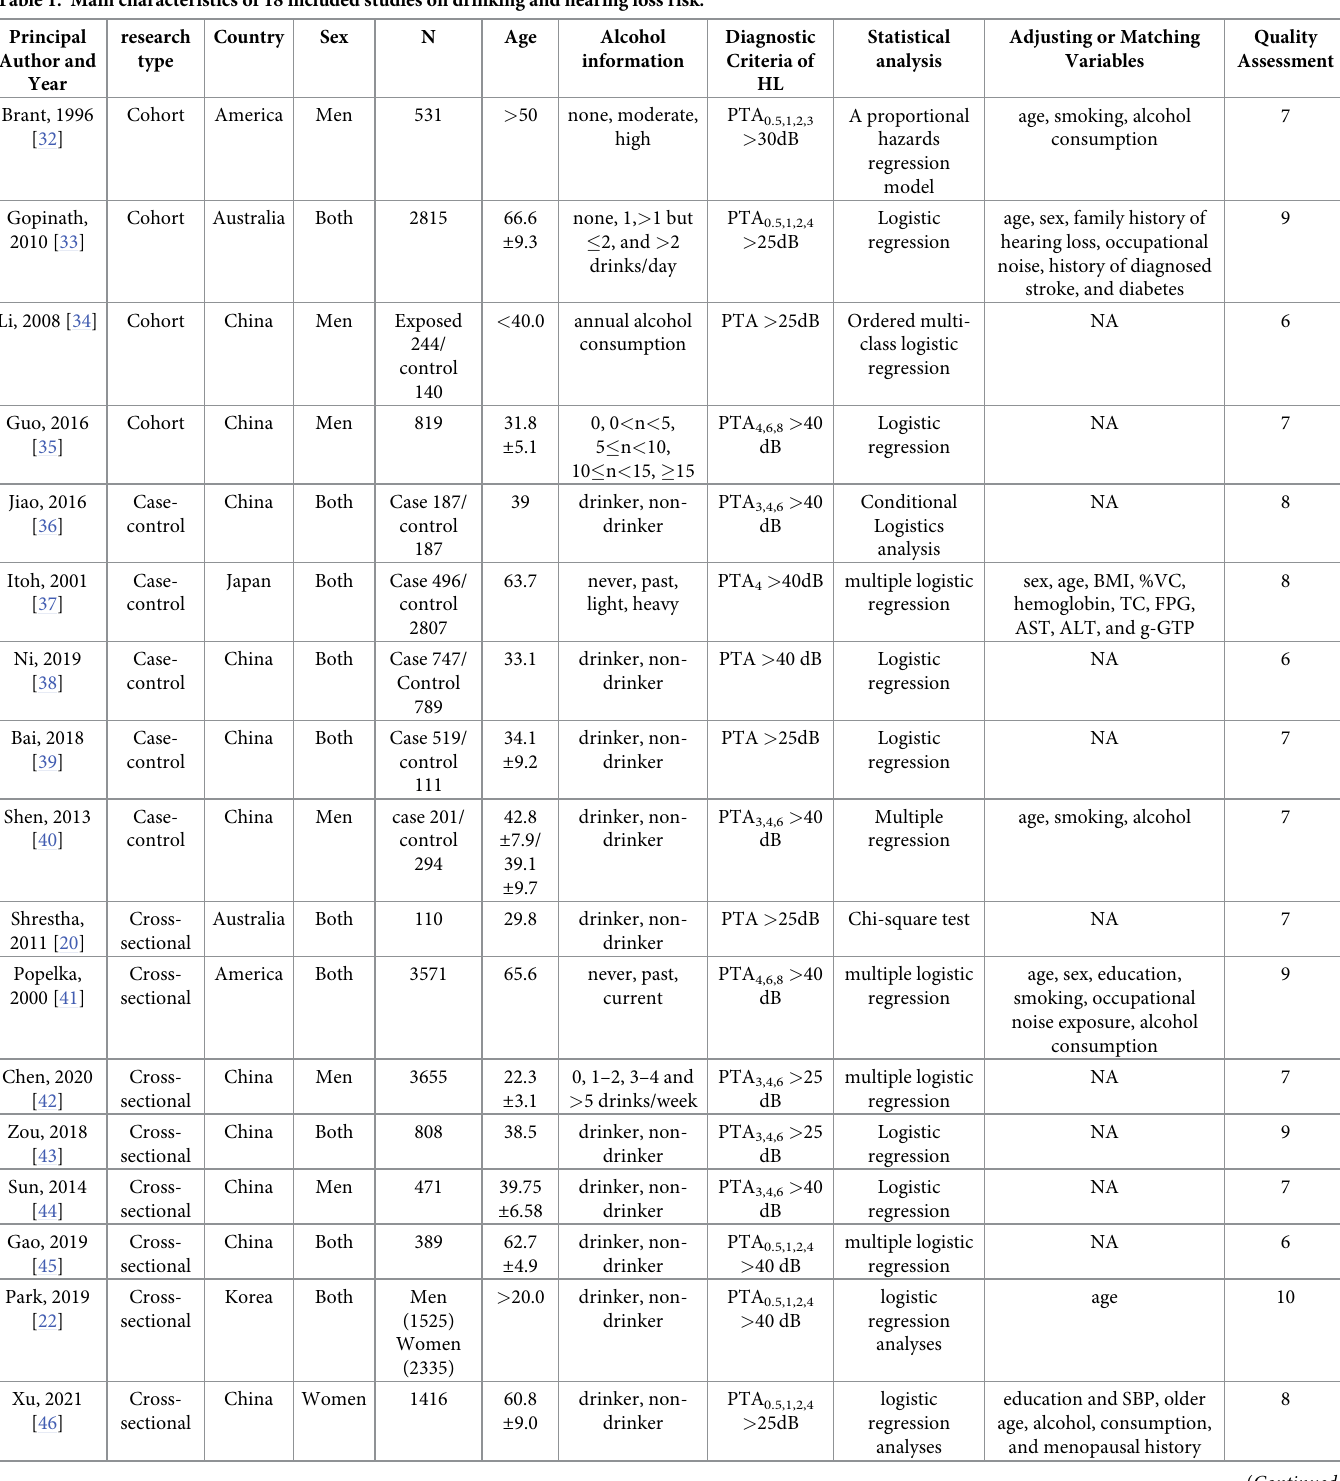
Table 1. Main characteristics of 18 included studies on drinking and hearing loss